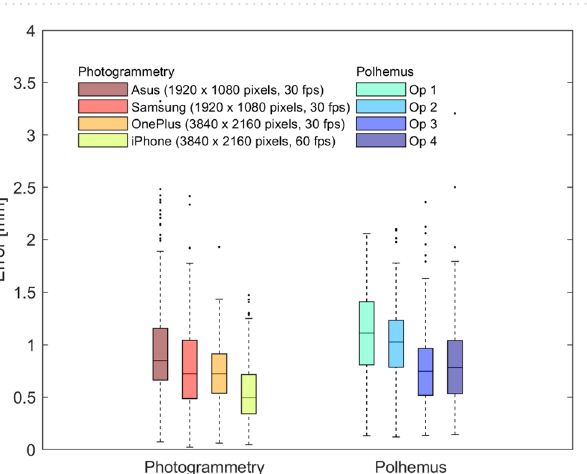
Figure 3. Deviation of the smartphone-derived meshes from the original phantom. Deviation values are represented with a colour code on the phantom model. Each value indicates the Euclidean distance between a node on the original phantom and the closest node on the reconstructed model.